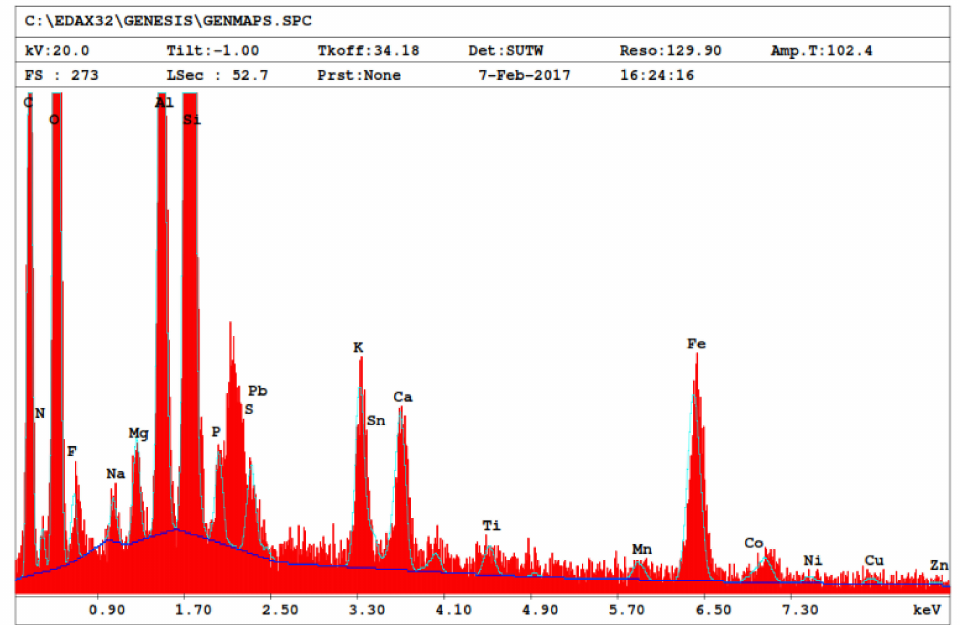
Figure 1. Elemental composition of the sludge: Wt%, mass percentage fraction; At%, atomic percent- age fraction determined by using the EDX